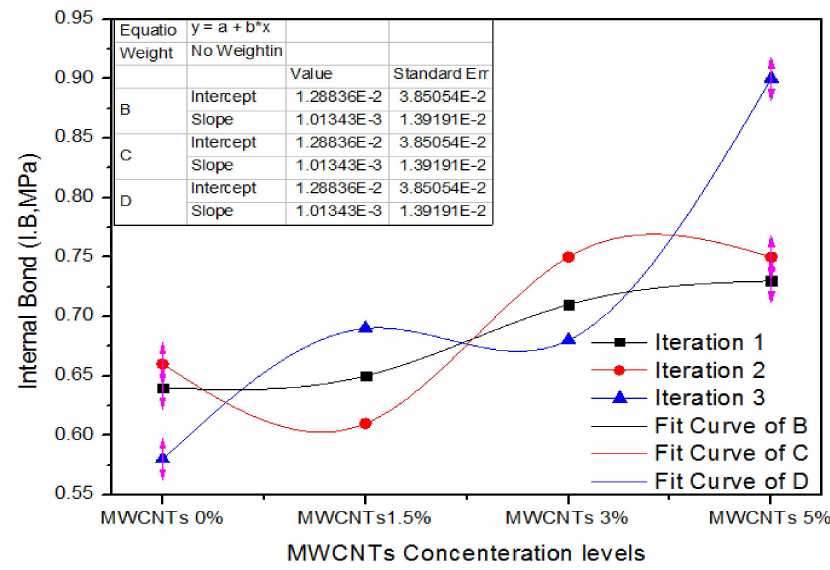
Figure 12. Internal bond values of different counts of